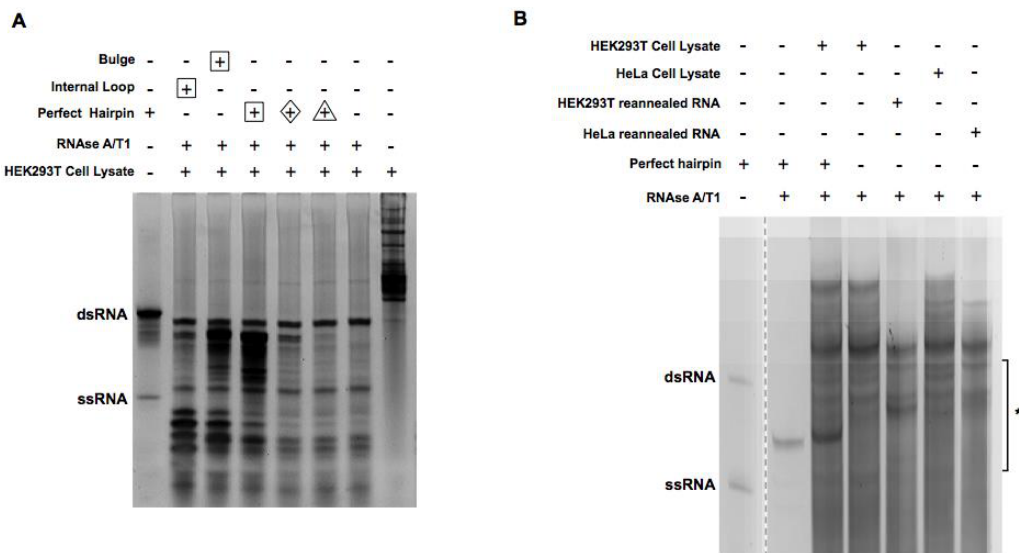
Figure 2. Digestion of cell lysate and reannealed RNA with RNAse A/T1. ( A ) HEK293T cell lysate spiked with different kinds of RNA duplex oligos were digested with 1:200 dilution of RNAse A/T1 at 37 °C for 30 min. RNA was extracted after digestion and separated on 15% acrylamide TBE native gels and stained with SYBR gold. Lanes with different amounts of spike-in RNA were labeled with different shapes ( (cid:52) , 0.1 µ g; ♦ , 0.5 µ g; (cid:3) , 5 µ g). The arrow indicates the band that was subject to more detailed investigation as described in Section 2.3. ( B ) Cell lysate and reannealed RNA with or without spiked-in were digested with 1:200 dilution of RNAse A/T1. * indicates where the bands were cut for cloning and